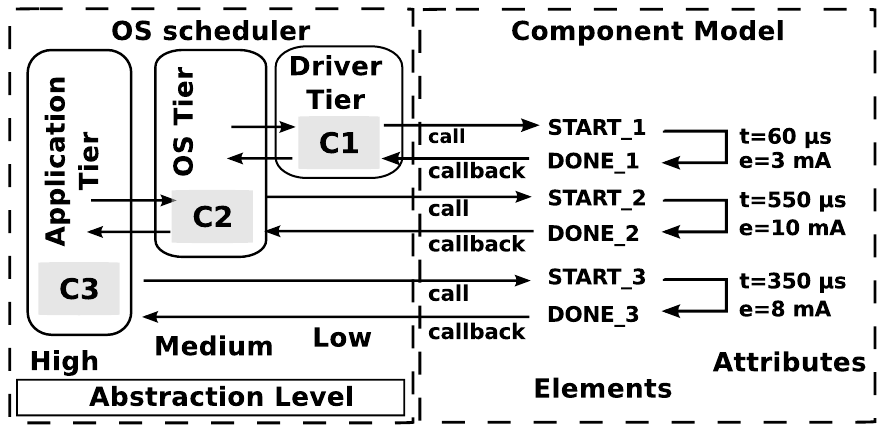
Figure 3. Model configuration using xml and hardware